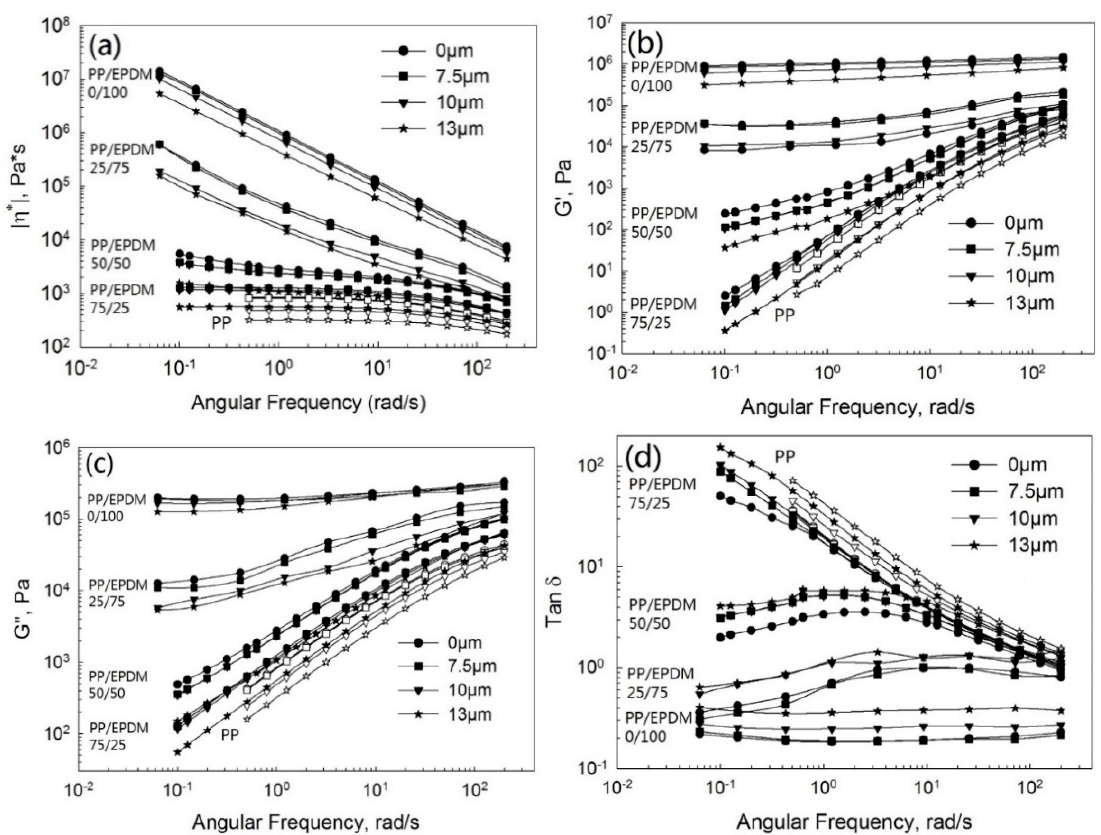
Figure 4. Complex viscosity ( a ), storage modulus ( b ), loss modulus ( c ), and loss tangent ( d ) as a function of the frequency for the pure PP, devulcanized EPDM, and PP/EPDM blends prepared by the OS method.